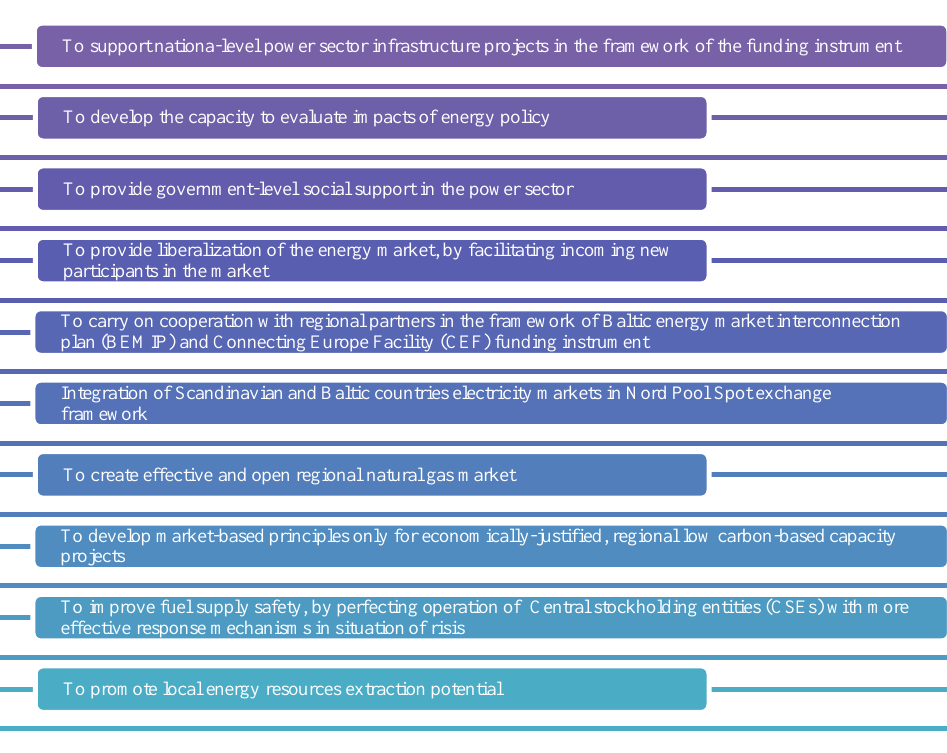
Fig. 6. Energy supply safety provision